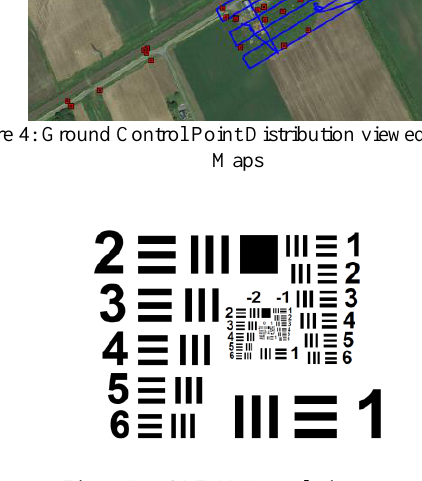
Figure 5: USAF 1951 resolution